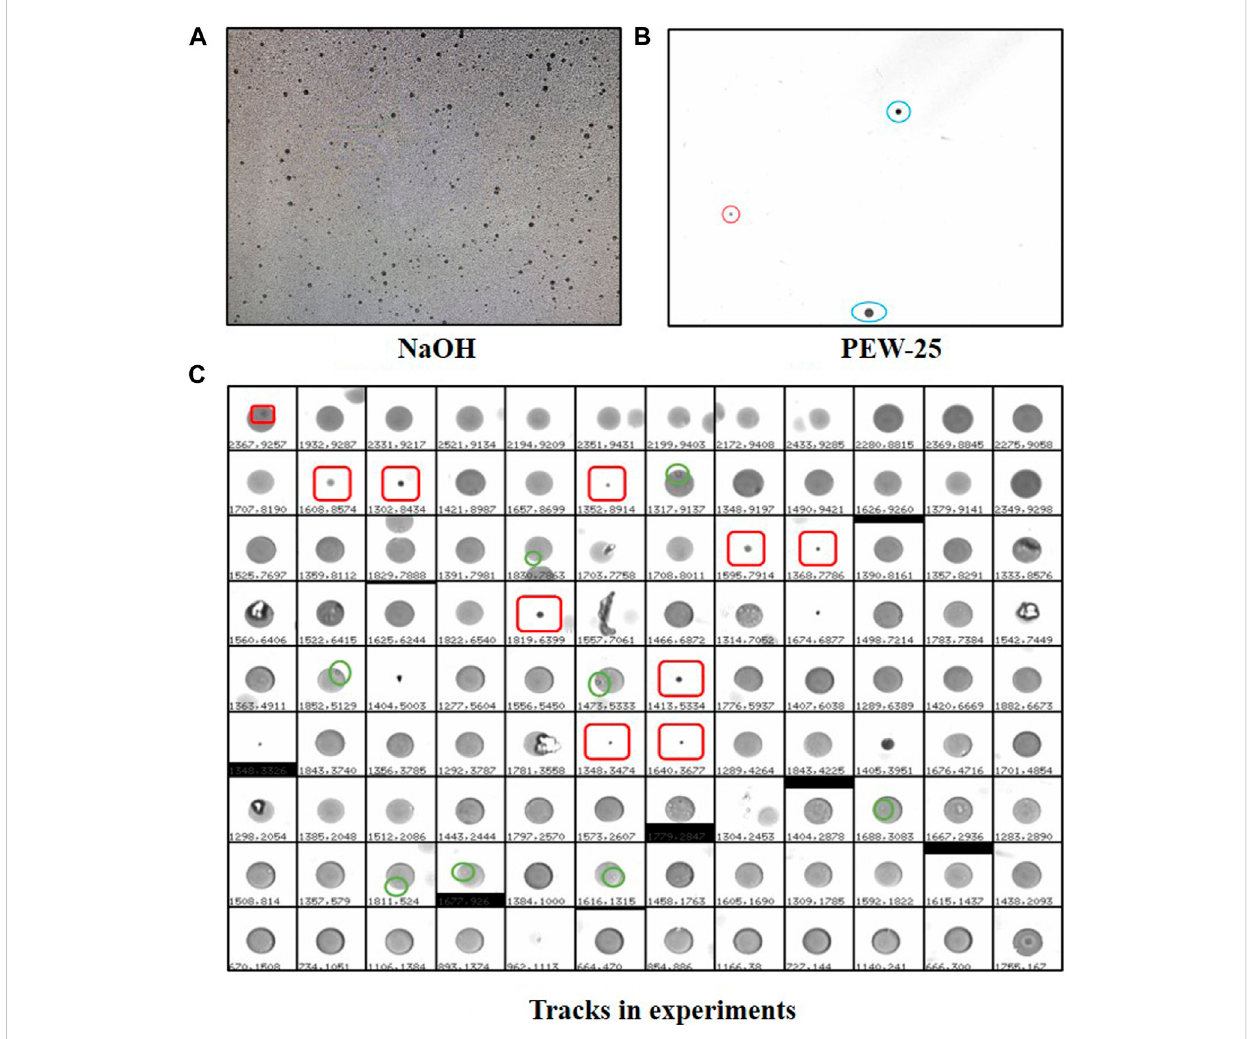
SurfacesofirradiatedCR-39afteretchingintheNaOH (A) andPEW-25 (B) solutions.Theblueencirclestracksof 11 B or 12 C in (B) ,andtheredregionis a track of α particles. (C) Tracks in the experiment with some tracks of α particle (red square). Tracks of heavier ions are much larger than those of α . The green circles in (C) indicate the overlapping of protons and